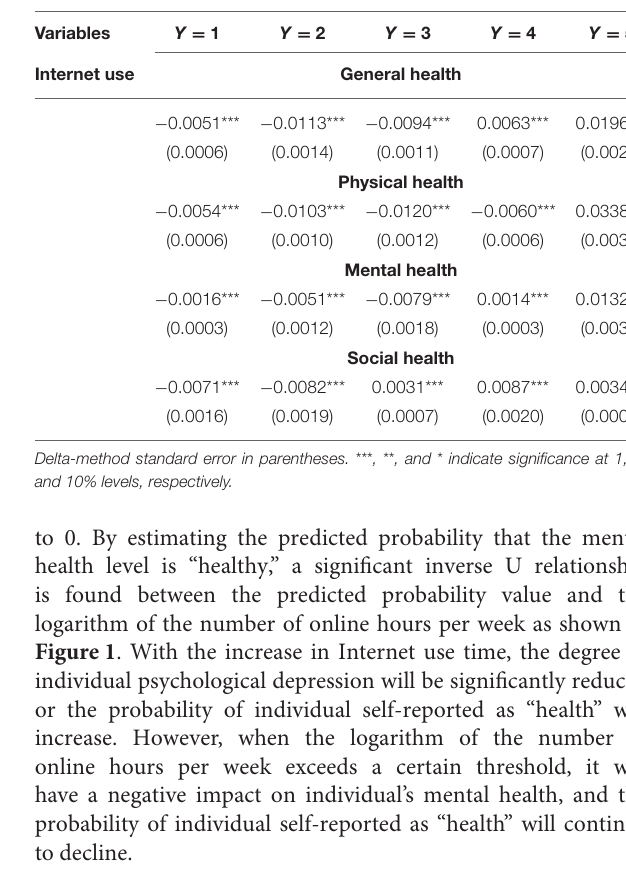
TABLE 3 | The marginal effect of oprobit model.